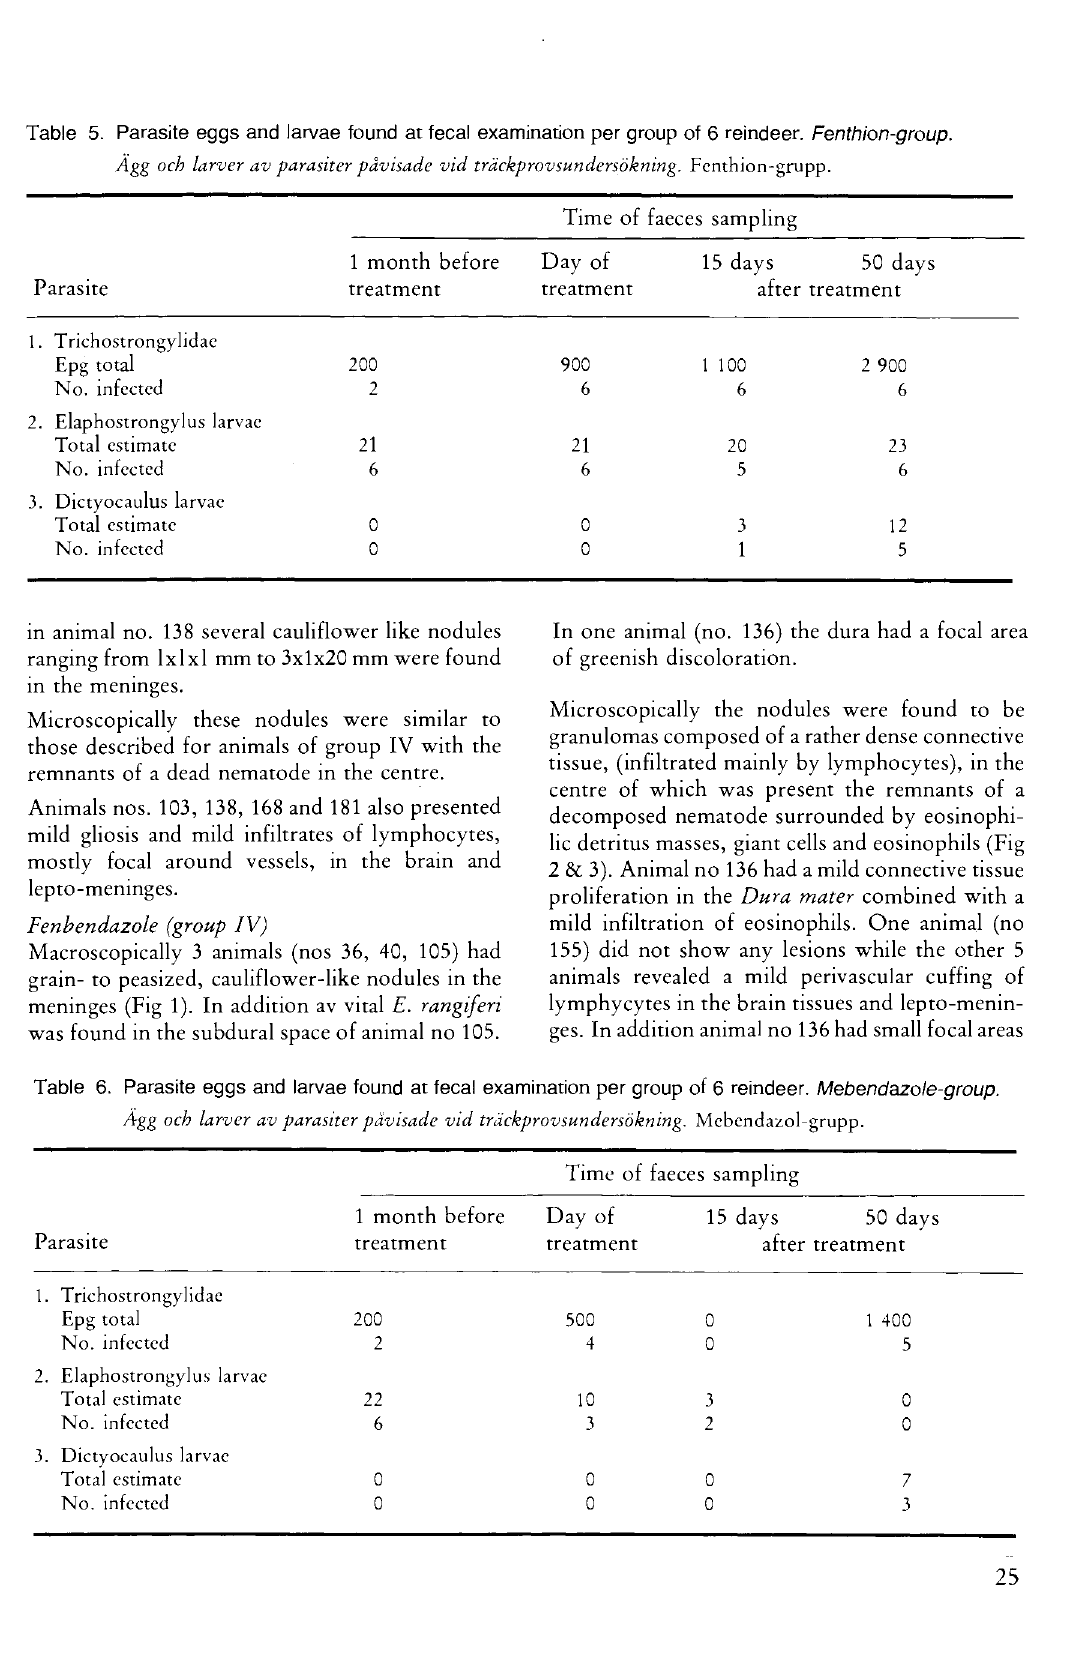
Table 5. Parasite eggs and larvae found at fecal examination per group of 6 reindeer. Fenthion-group.